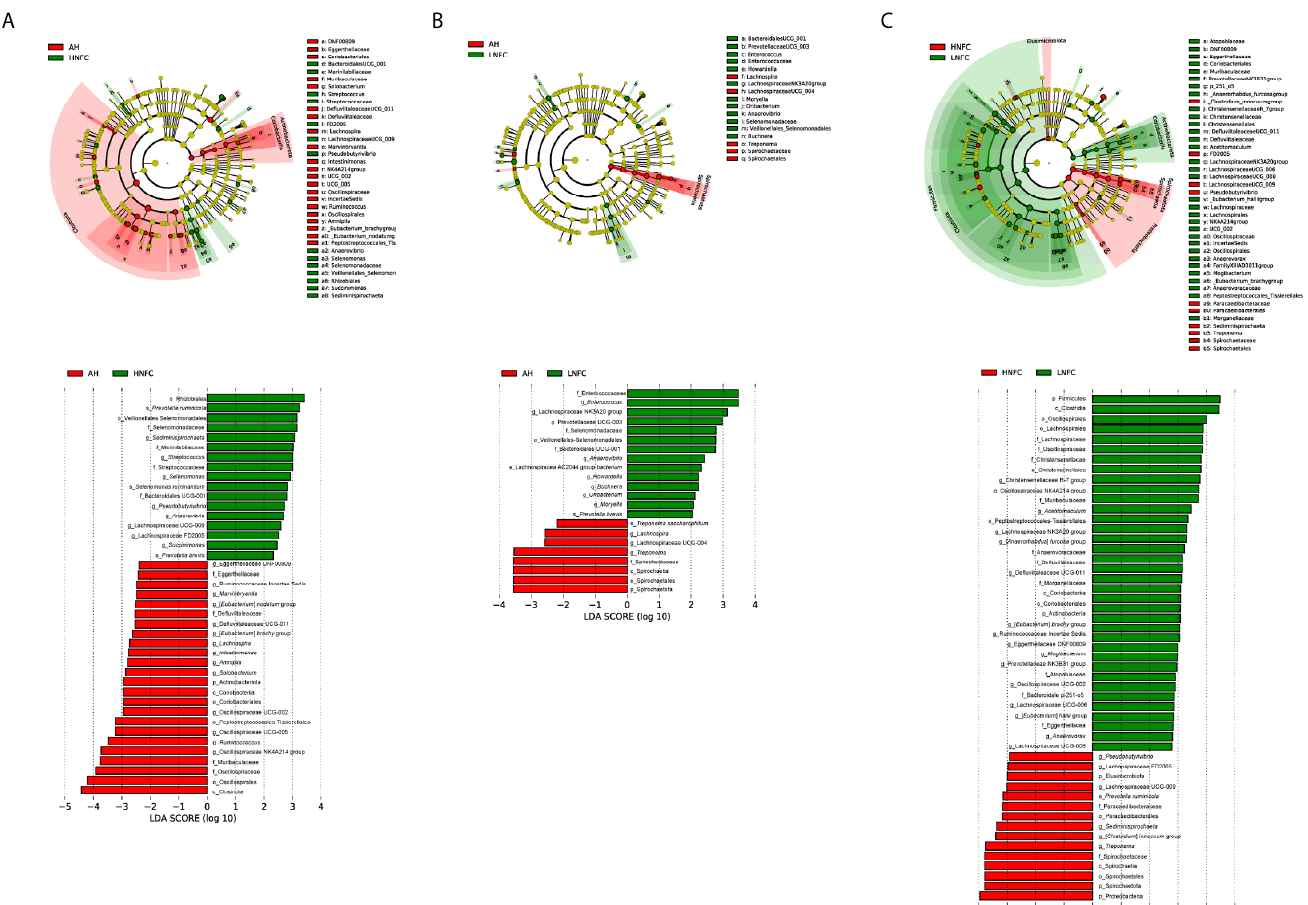
Figure 3. Linear discriminant analysis (LDA) between microbiota from ( A ) alfalfa based diet (AH) and a CS based diet with high NFC (H-NFC); ( B ) AH and CS based diet with low NFC (L-NFC); ( C ) H-NFC and L-NFC. Differences are represented by color of the group, where taxa are most abundant. Histogram of LDA scores computed for each taxon ranging from phylum to species. The LDA scores represented the difference in relative abundance with exponent fold change of 10 between two communities.